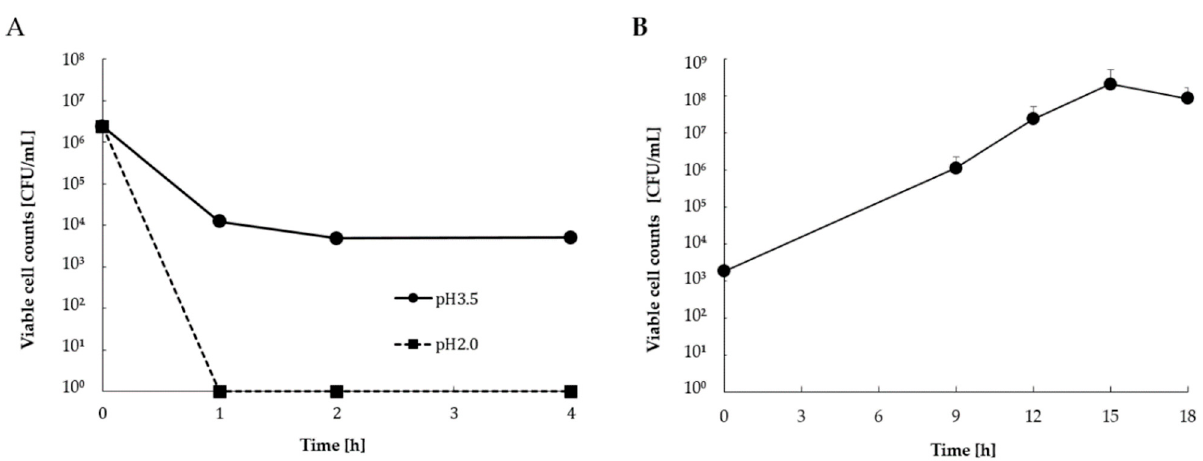
Figure 2. Viable cell counts of L. casei 001- fermented Hidakakombu in simulated gastric ( A ) and intestinal ( B ) juices (mean ± standard deviation (SD); n = 4).